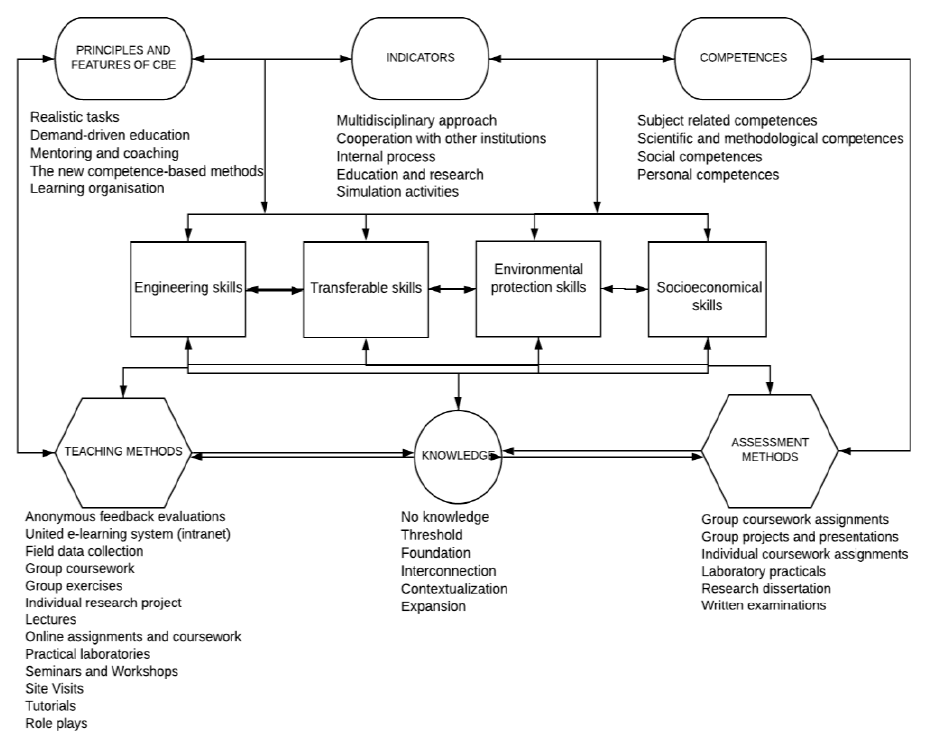
Fig. 4. Assessment framework for the evaluation of environmental engineering study